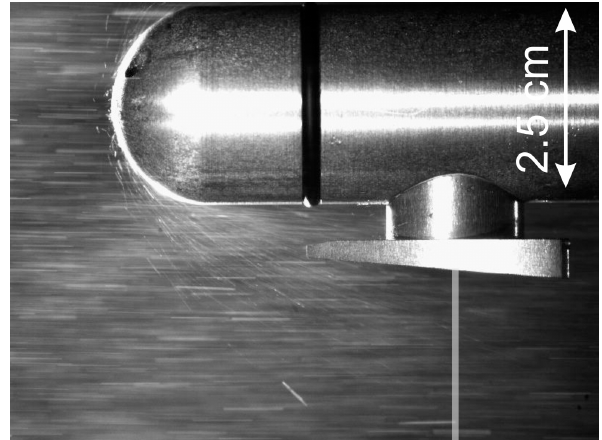
Figure 15. A snapshot from a high-speed video showing a flow of shattered ice fragments rebounding from the hemispherical tip of the OAP-2DC particle probe. The shattered ice fragments de- flected toward the sample area (bright vertical band) are counted by the probe and artificially enhance the measured concentration. The video recording was performed in an ice spray at 80ms − 1 in the Cox and Co. Icing Wind Tunnel Facility (for more details see Korolev et al., 2011, 2013a,